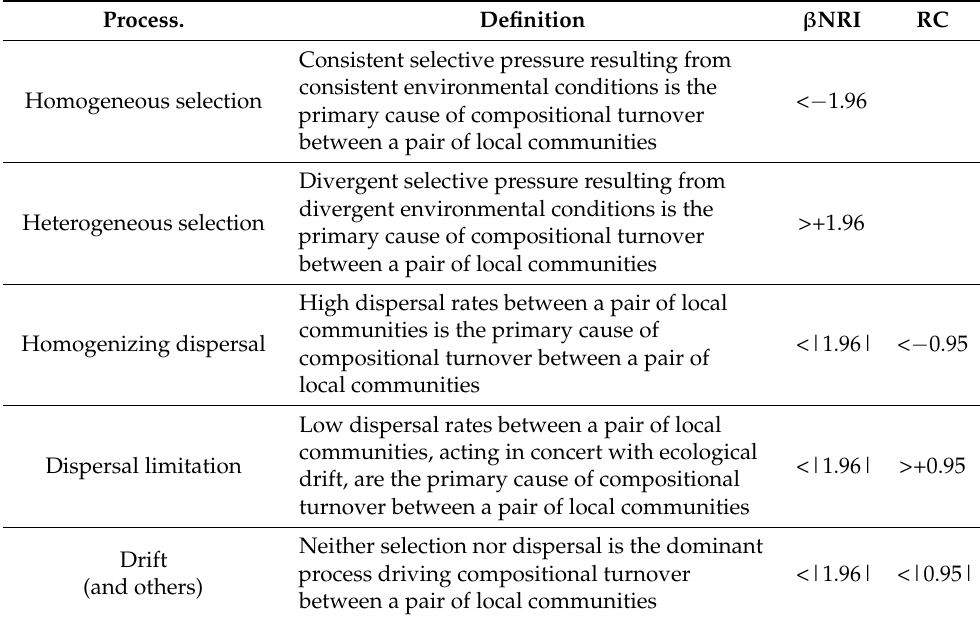
Table 1. Criteria to quantify the importance of ecological process accounting for the turnover between communities following Ning et al.